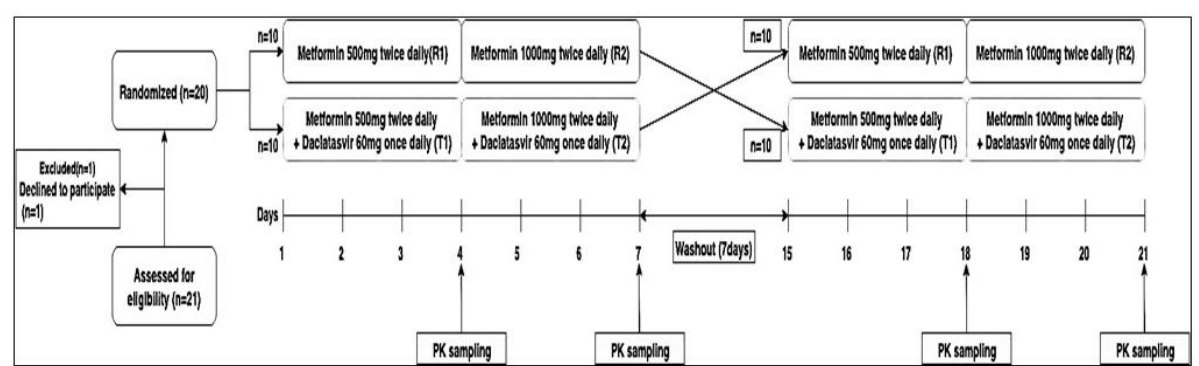
Fig.1. Flow chart of study